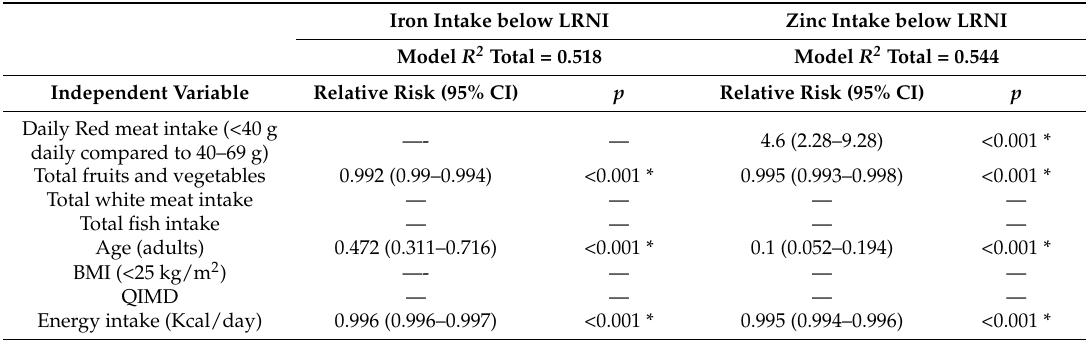
Table 3. Logistic regression models to predict iron and zinc intake below lower RNI ( n =